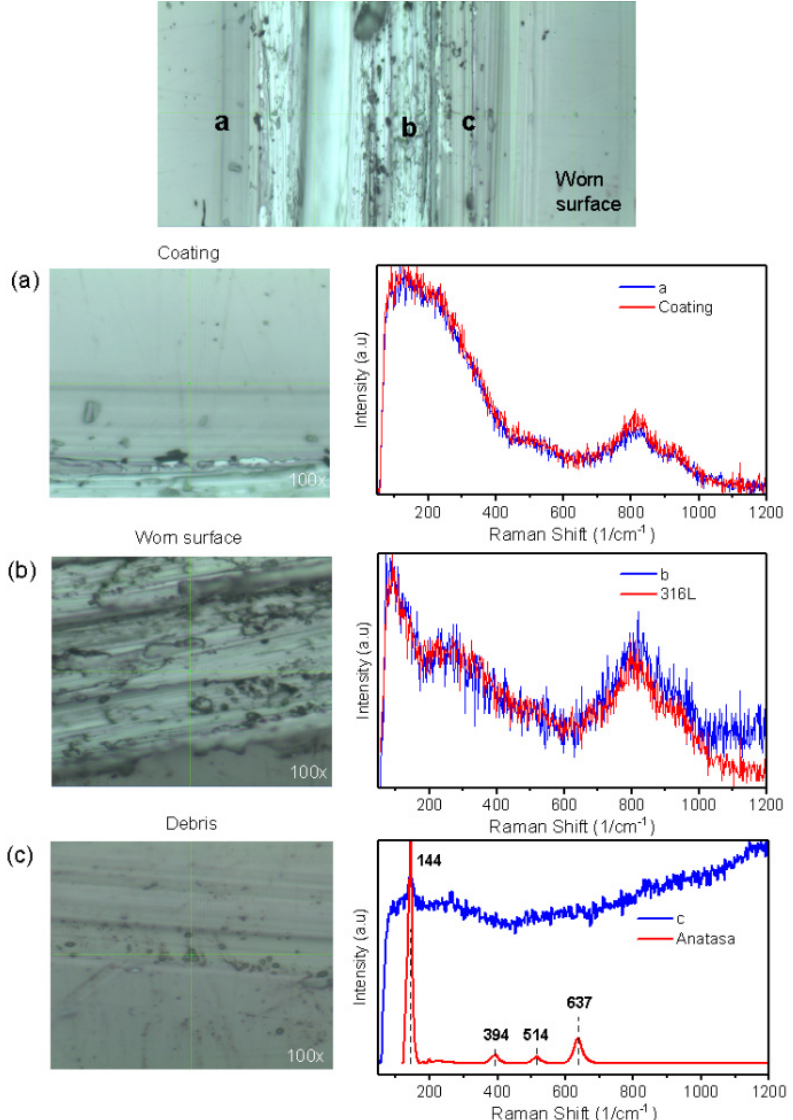
Figure 10. Raman spectroscopy analysis of the wear trace of the AlTi coating. ( a ) Raman spectra of coating; ( b ) Raman spectra of worn surface; ( c ) Raman spectra of debris.